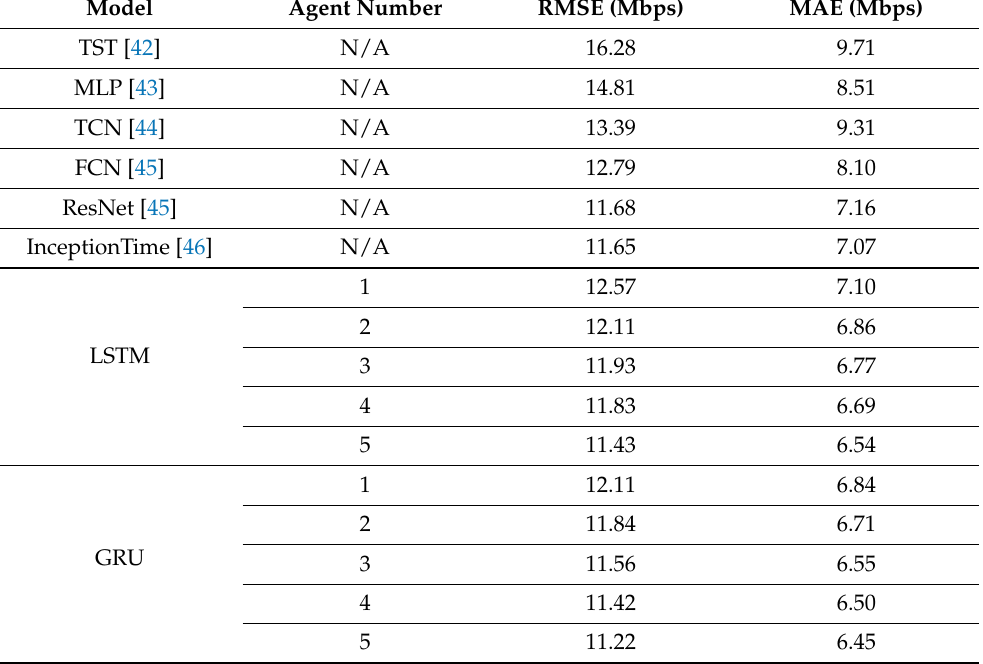
Table 1. The experimental results.